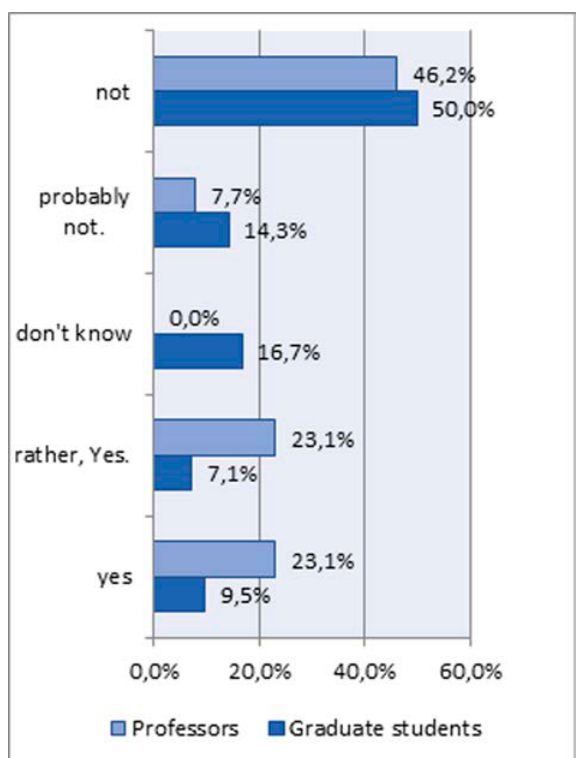
Fig. 2. Respondents' opinions on the comprehensibility of the goals of the reform of the faculty.